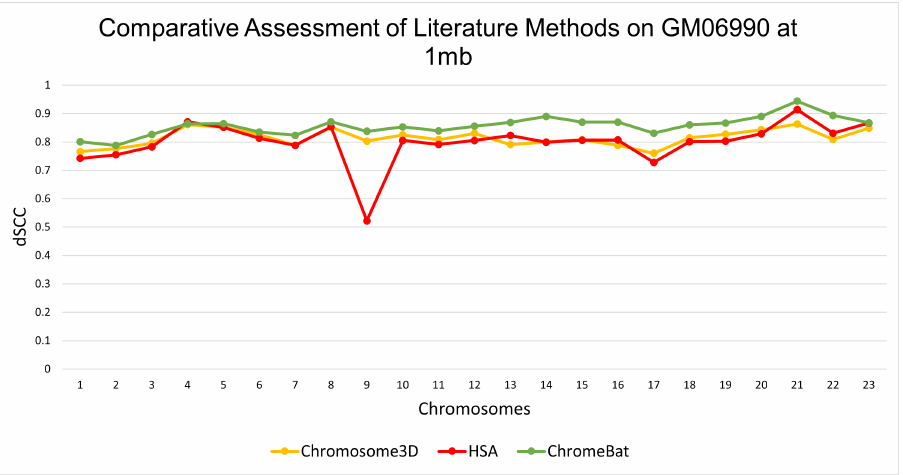
Figure 5. Comparative Assessment of Metaheuristic Methods on GM06990. A comparison of the distance Spearman Correlation Coefficient (dSCC) between metaheuristic methods Chromosome3D, HSA, and ChromeBat. This experiment is performed on the first 23 chromosomes of the GM06990 cell line at 1 mb resolution using restriction enzyme